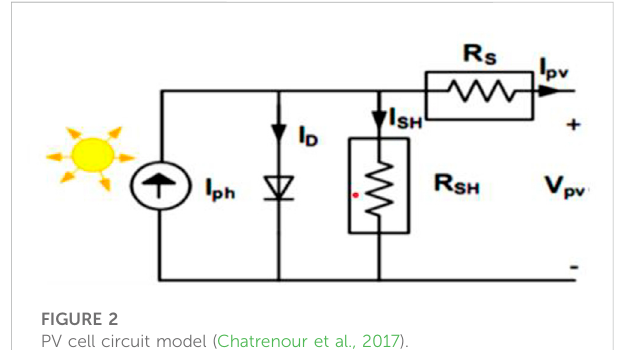
FIGURE 2 PV cell circuit model (Chatrenour et al.,